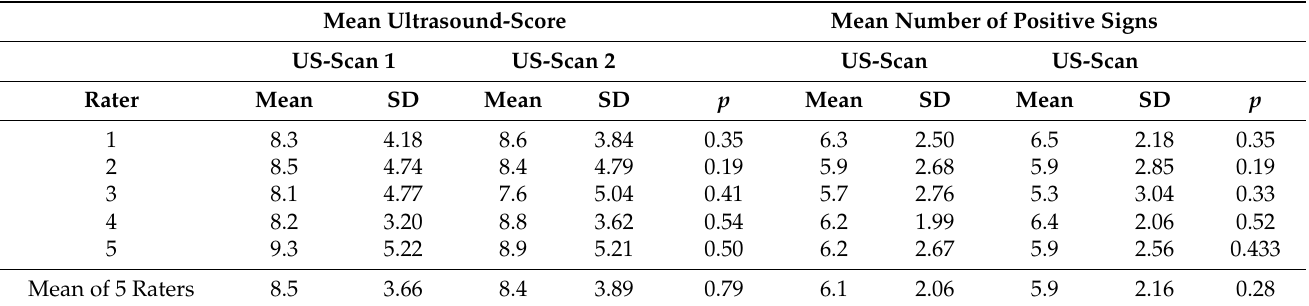
Table 3. Mean number of positive signs and the mean “US-Score” (number of positively scored signs and their estimated severity) as rated by each rater. Rater 1 represents the expert sonographer.